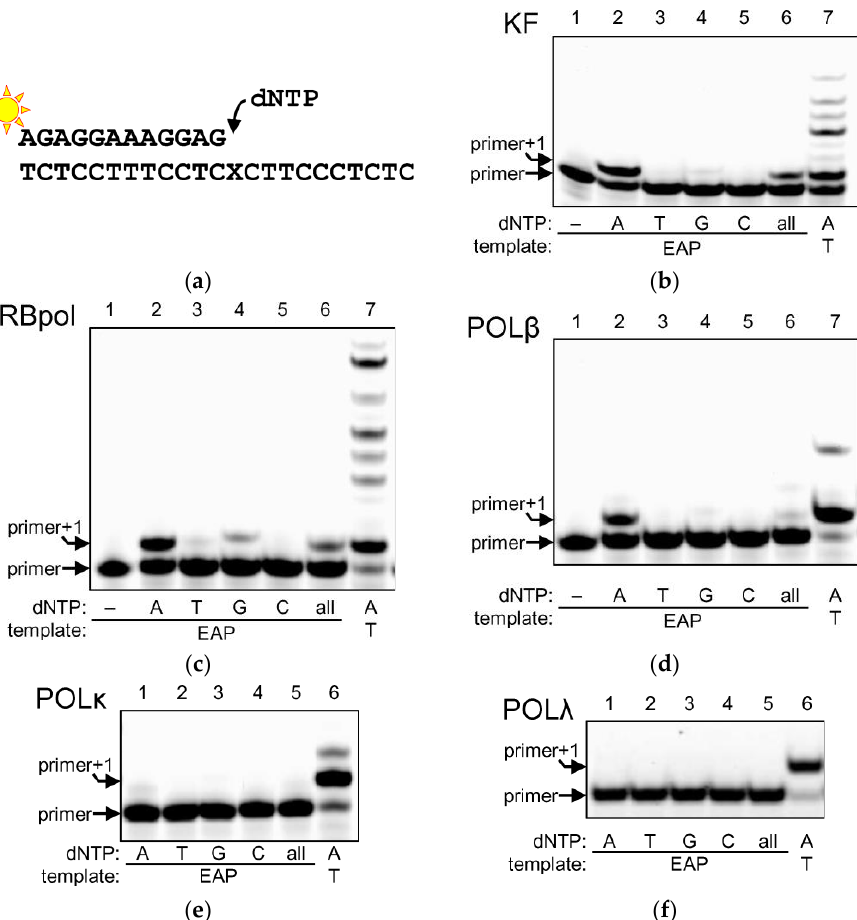
Figure 2. Incorporation of dNMPs by DNA polymerases opposite EAP. ( a ) Fluorescently labeled primer-template substrate used in the experiments. ( b – f ) Incorporation of dNMPs by KF ( b ), RBpol ( c ), POL β ( d ), POL κ ( e ) and POL λ ( f ). The nature of the substrates is indicated below the representative gel